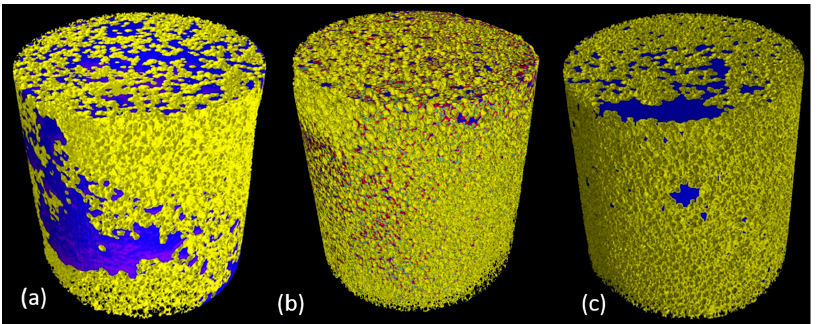
Figure 4. 3D rendering of sponge with magnetite powder dispersed olive oil ( a ) before cleaning, ( b ) intermediate Process 3 (Section 2.7) and ( c ) after two stages of cleaning. Pseudo coloration is performed based on the segmentation: blue represents magnetite powder dispersed olive oil, pale blue represents water, red represents detergent and yellow colour represents the sponge. The residue was present even after 2 stages of cleaning for the magnetite powder dispersed olive oil sponge.